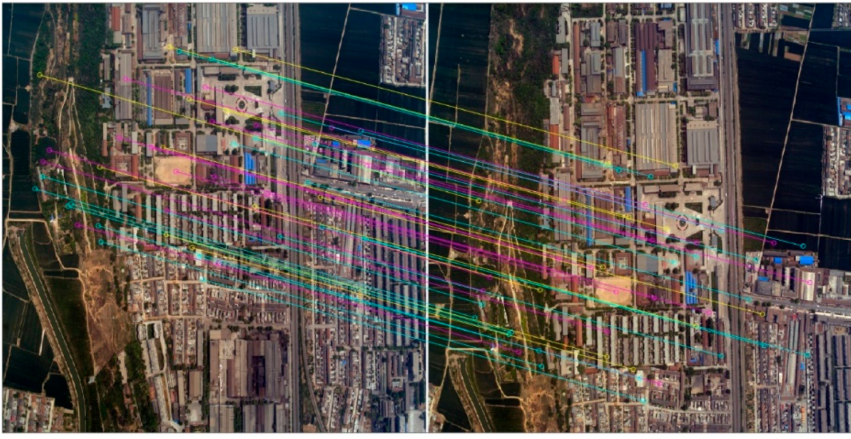
Figure 8. Partial view of the tie points obtained by SIFT (showing only 50 tie